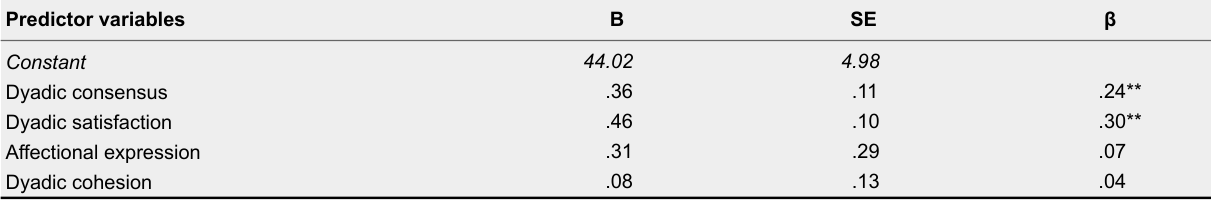
Predictors of Parenting Alliance in Fathers (N = 236)